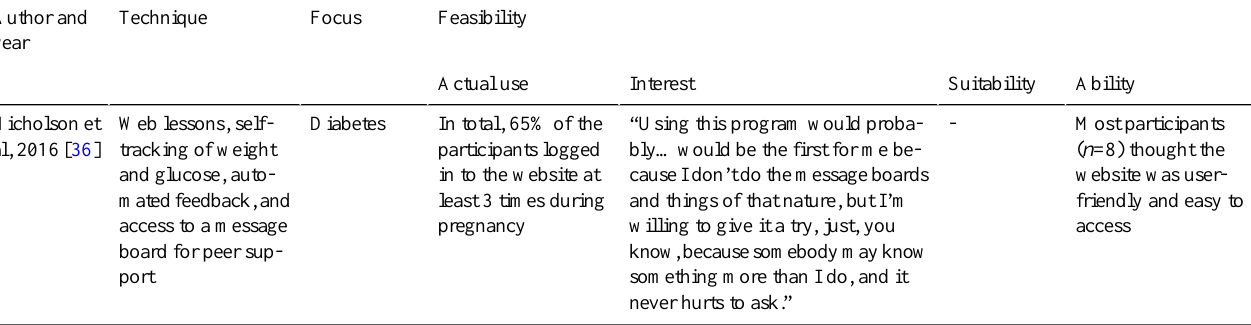
Table 1. Overview of studies reporting on medical (interventions) apps related to pregnancy: feasibility. FeasibilityFocusTechniqueAuthor